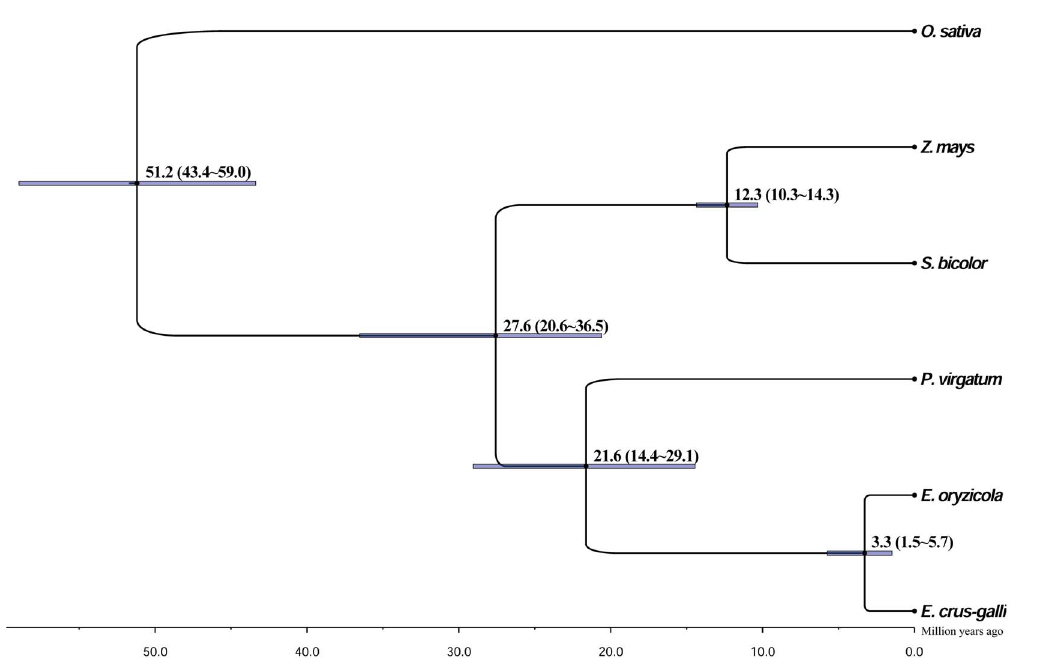
Figure 4. Divergence time of the genus Echinochloa . Divergence time was estimated using BEAST based on the complete chloroplast genomes of six species ( E. oryzicola , E. crus-galli , P. virgatum , S. bicolor , Z. mays , and O. sativa ). The numbers showed at nodes indicate divergence time.